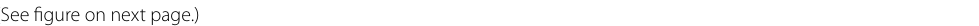
figure on next Fig. 4 PET images of 18 F‑C2Am in tumor‑bearing mice, pre‑ and post‑treatment. Maximum intensity projections of the PET signal in sagittal sections of representative mice, bearing MDA‑MB‑231 ( a ) and Colo205 ( b ) tumors. Projections are shown from immediately before (0) and up to 120 min after injection of 18 F‑C2Am. Signal is shown as injected activity per gram of tissue (IA/g, %) and overlaid on a CT‑derived skeleton mask. White arrows indicate tumor location. Time–activity (IA/g, %) curves for the indicated tissues in treated (MEDI3039, 0.4 mg/kg, 24 h) MDA‑MB‑231 ( c ) and Colo205 ( d ) tumor‑bearing mice. Also shown are tumor‑to‑blood (T/b) and tumor‑to‑muscle (T/m) ratios for both tumor models. e , f Pairwise analysis of PET signal pre‑ and 1 h (first and third columns) or 2 h (second and fourth columns) post‑treatment, expressed as IA/g (%) ( e ) or SUV ( f ). Pairwise analysis ( g ) of tumor bioluminescence pre‑ and post‑treatment (first and third plots) and correlation analysis (Pearson) of tumor PET signal with the reduction in BLI signal (second and fourth plots), 1 h after 18 F‑C2Am administration. Data ( c , d ) is mean group. Black and red symbols ( e , g ) correspond to MEDI3039 treatment at 0.4 or 0.1 mg/kg (for 24 h), respectively. e , g Two‑tailed, pairwise t test, unequal variance. * P < 0.05, ** P <